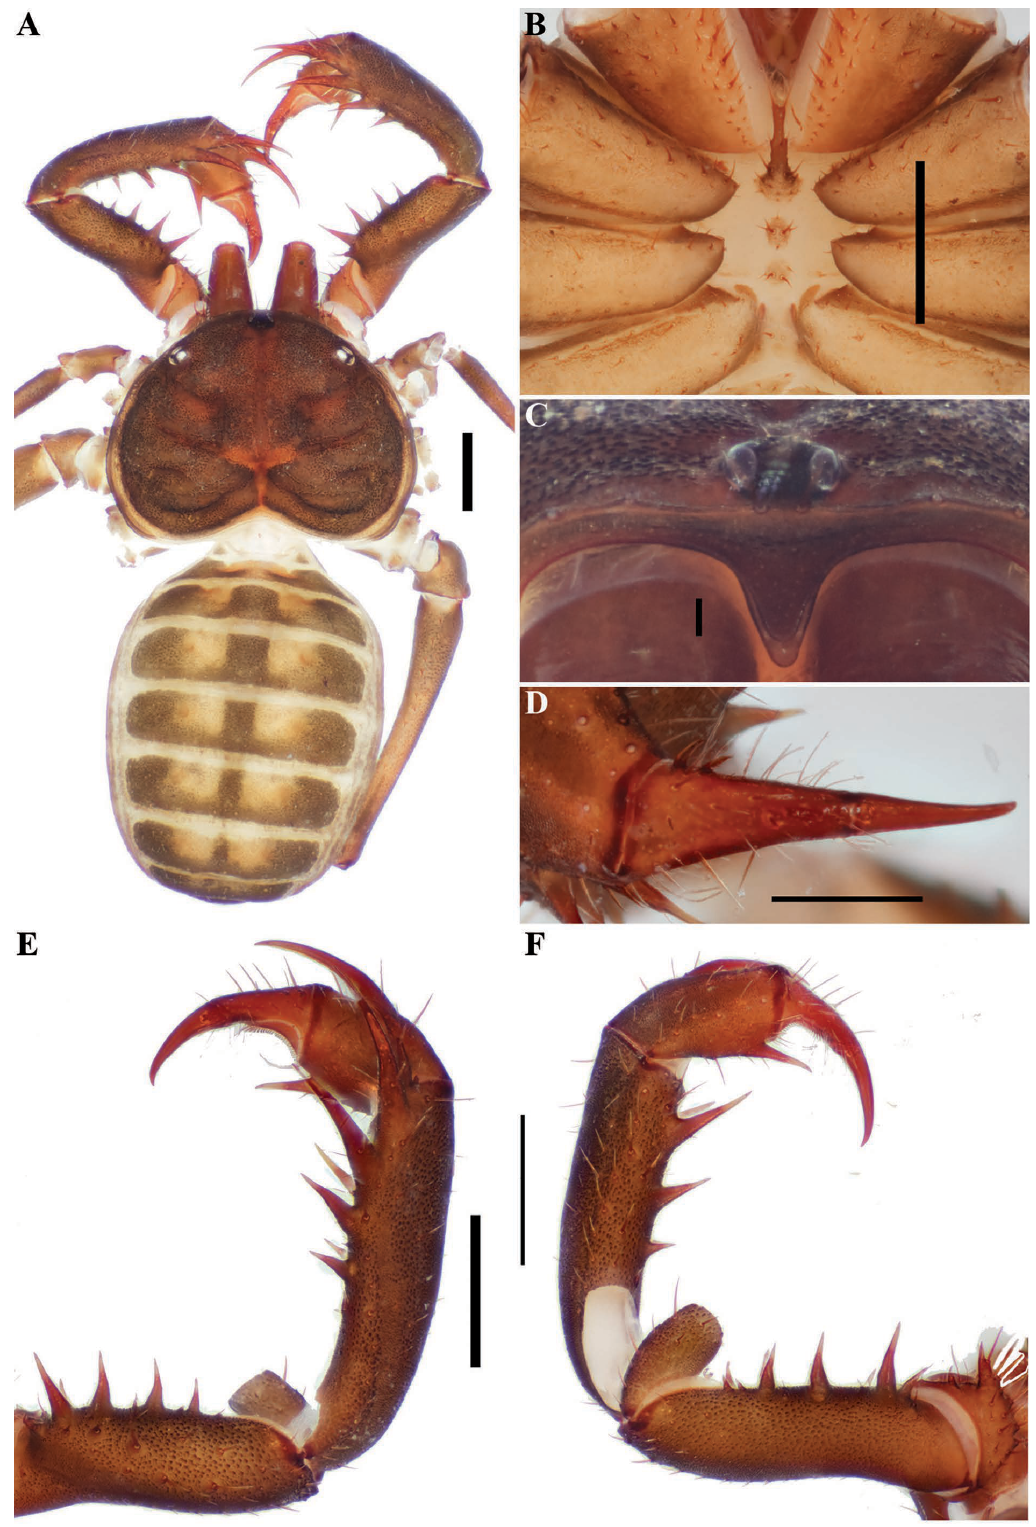
Fig. 108. Sarax brachydactylus Simon, 1892 (AMCC [LP 1926]), general morphology, ♀. A . Habitus, dorsal view. B . Sternum, ventral view. C . Frontal process. D . Pedipalp tarsus, frontal view. E . Pedipalp, dorsal view. F . Pedipalp, ventral view. Scale bars: A–B, D–F = 1 mm; C = 0.1